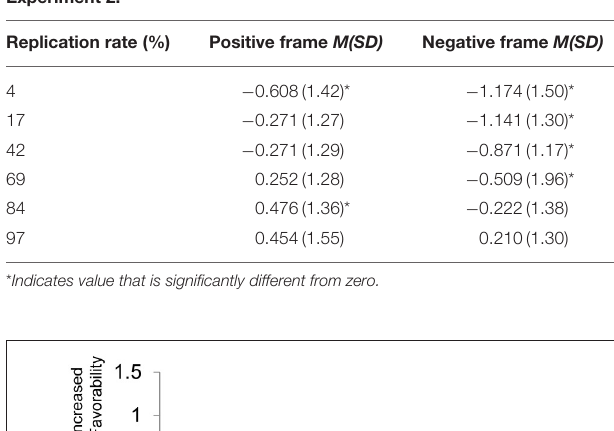
TABLE 3 | Mean and standard deviation of difference scores for Experiment 2.